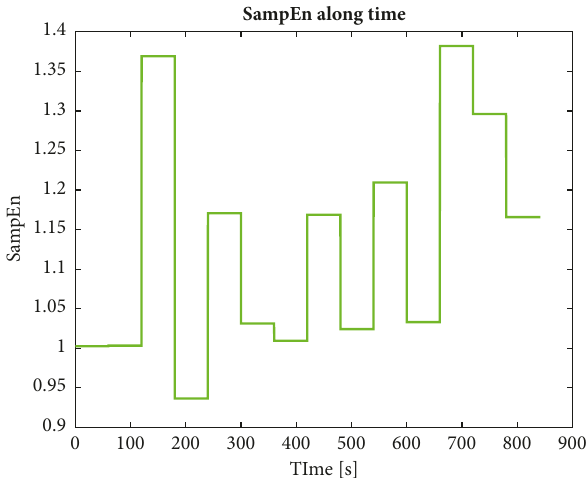
Figure 7: SampEn along time for the studied APRM stable signal.